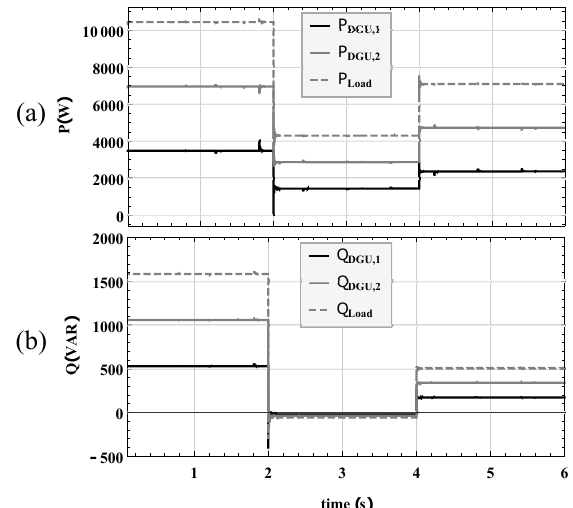
Figure 21. Individual DGU and overall load ac ( a ) Real and ( b ) Reactive powers. Real and reactive powers sharing is maintained according to a 1:2 ratio.